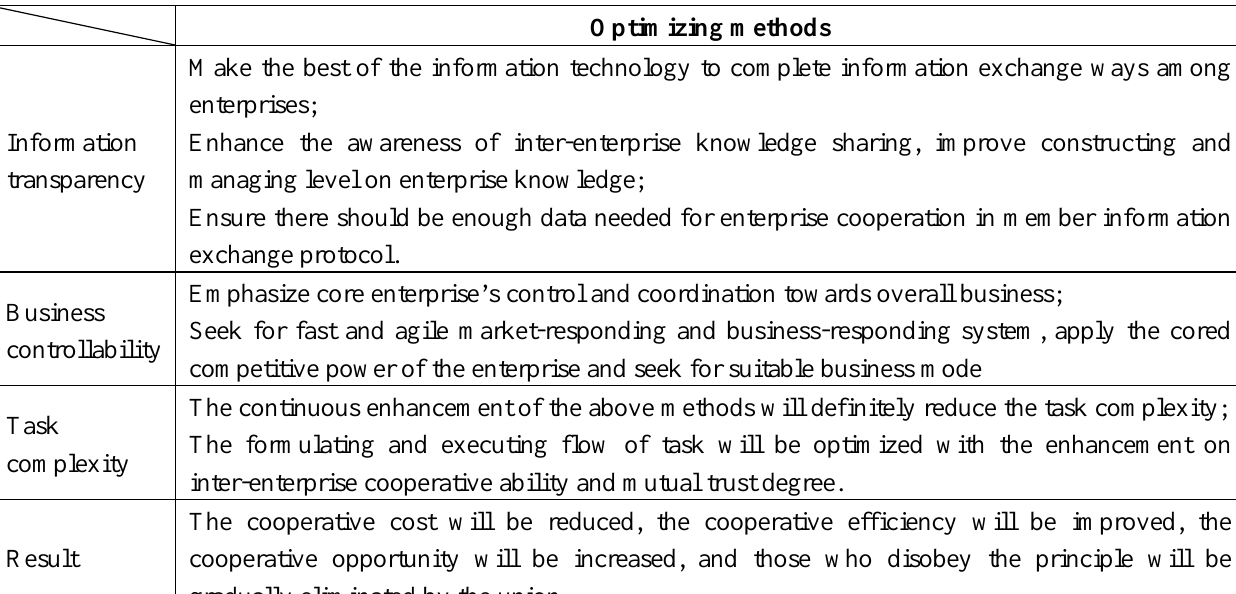
Table 2. Coordinative strategy adopted by LCA